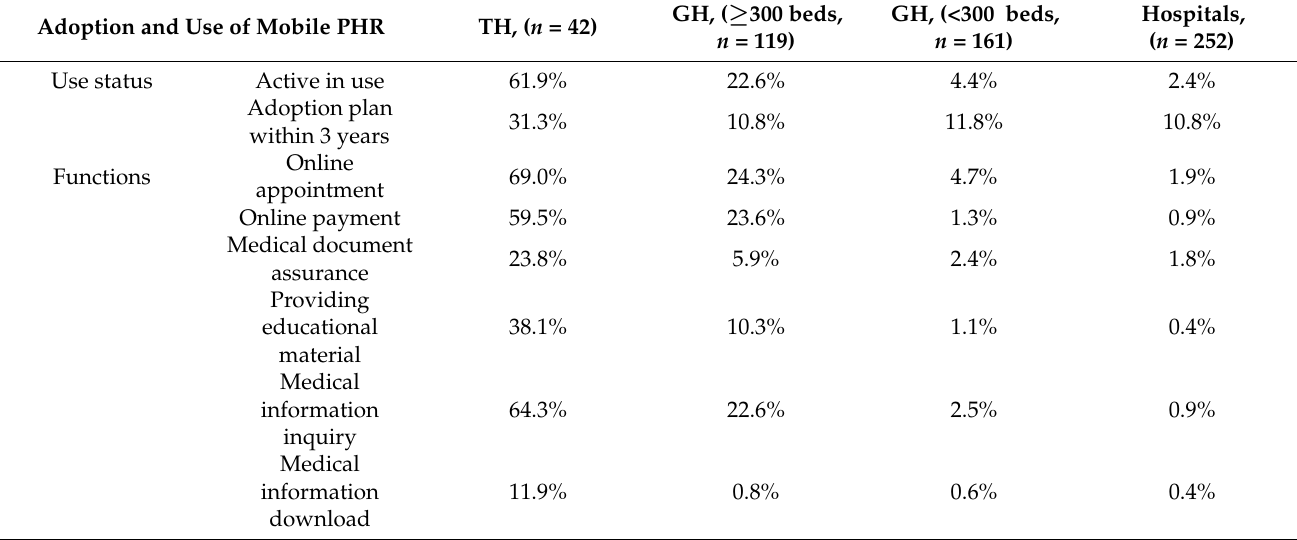
Table 3. Status, plan, and functionality of mobile PHR between